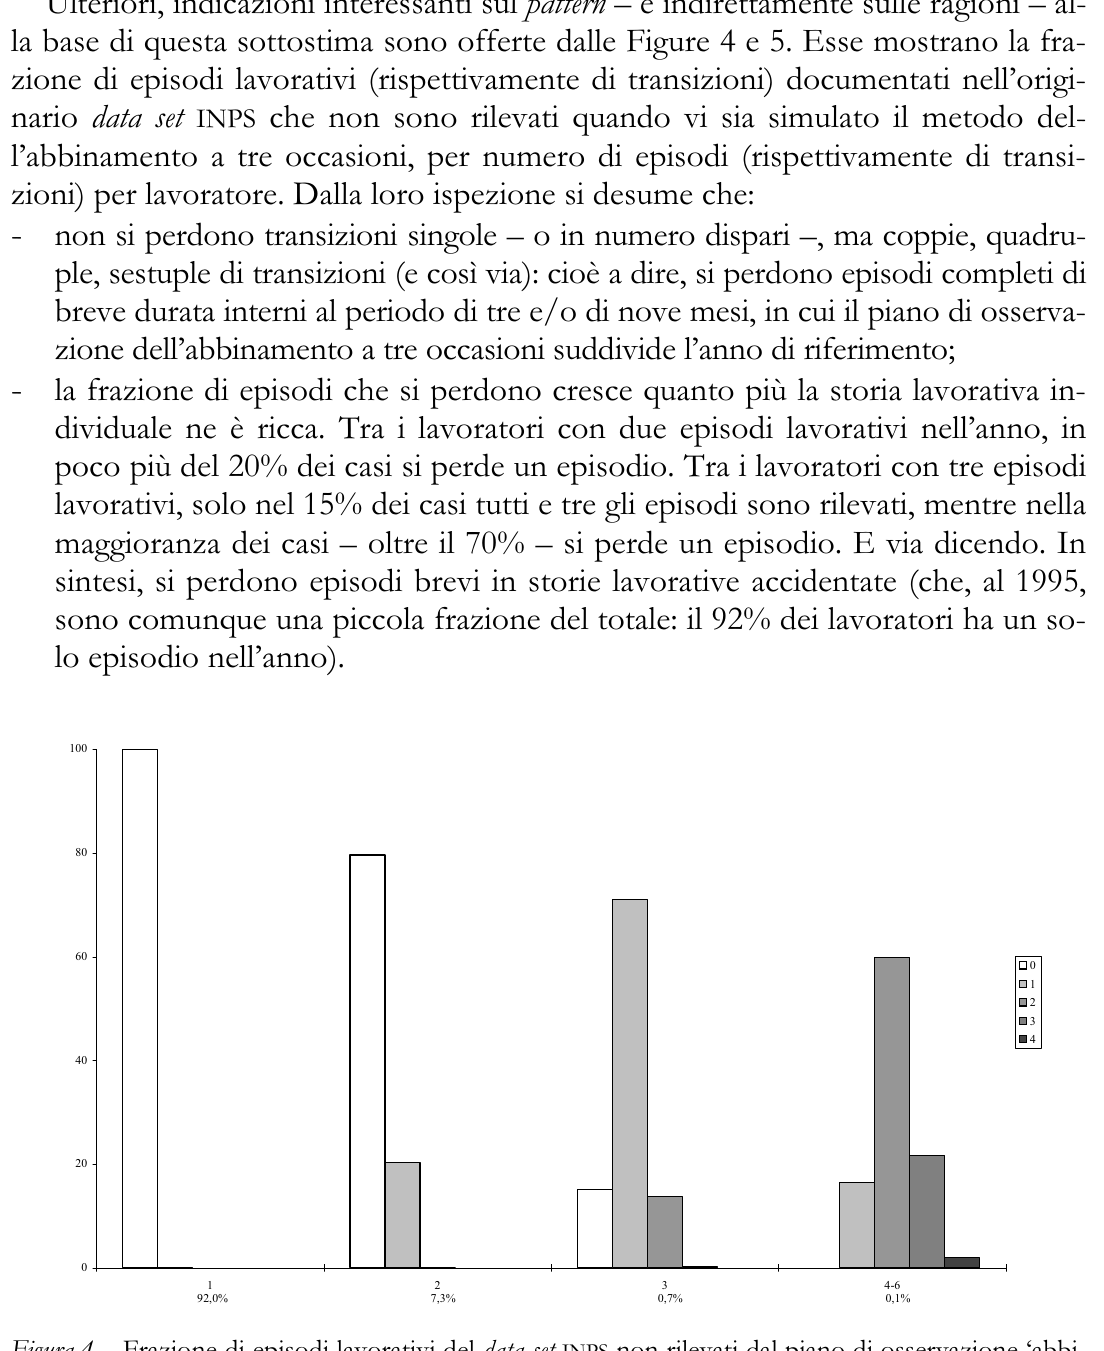
Figura 4 – Frazione di episodi lavorativi del data set INPS non rilevati dal piano di osservazione ‘abbi- namento a tre occasioni’, per numero di episodi per lavoratore (anno 1995; popolazione standardiz- zata; totale lavoratori: